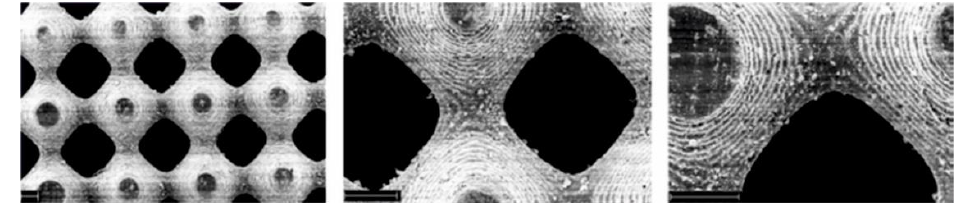
Figure 11. SEM images of porous structures with Schwarz primitive pore network architecture